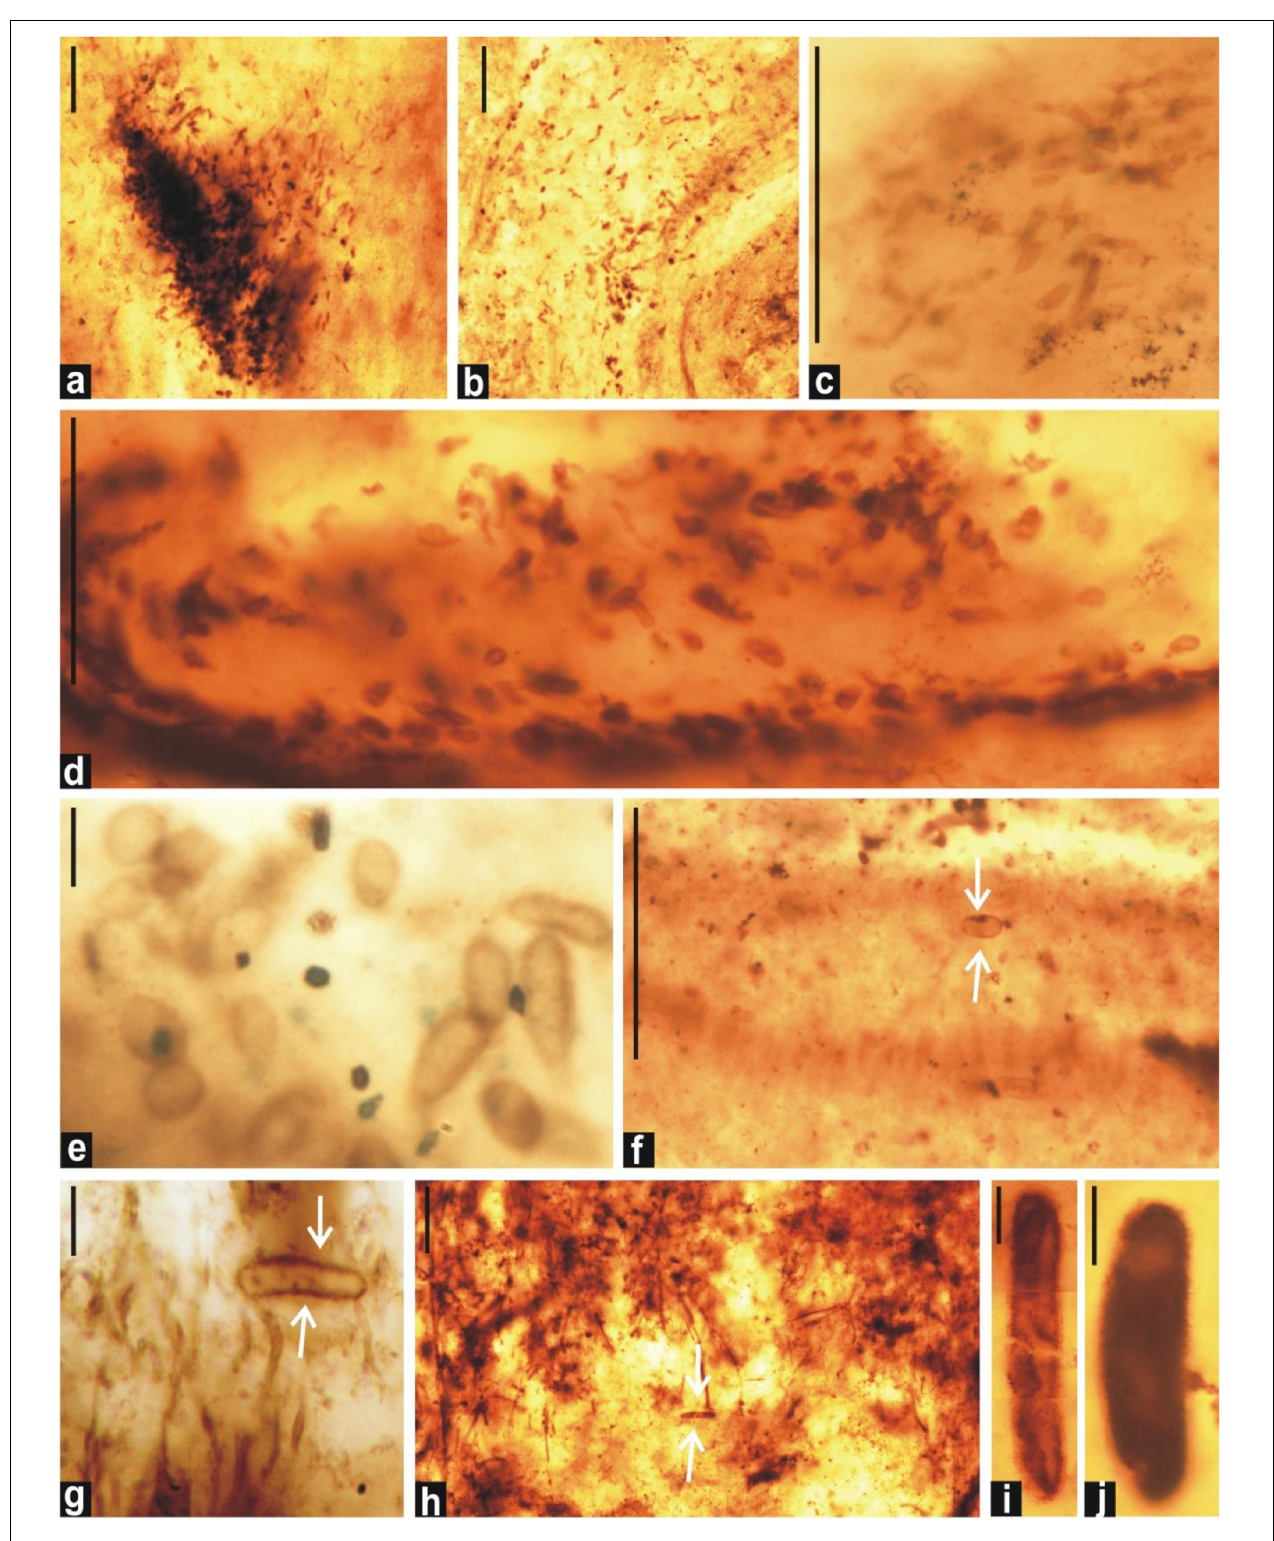
FIGURE 7 | Distribution pattern of small-sized akinetes observed in petrographic thin sections of the black chert of the Salkhan Limestone. Assemblage showing the cluster and random distribution of Archaeoellipsoides (a–e) . Note the occurrence of solitary individual of Archaeoellipsoides (marked by arrow) entangled in the radial fan-fabric (f) . Individual Archaeoellipsoides (marked by arrow) are shown along with the filamentous cyanobacteria (g,h) . Archaeoellipsoides shown in (a–g) represent A. minor , (h,i) A. conjuctivus , and (j) A. elongatus . Specimens a–d, f , and h are photographed at low magnification and scale bars represent 100 µ m whereas scale bars in e,g,i , and j represent 10 µ